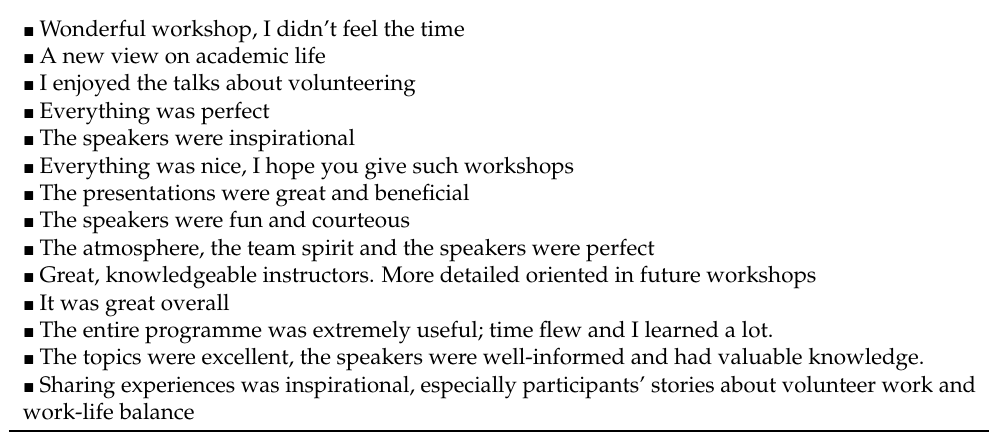
Table 4. Participants’ overall impressions of the workshop.